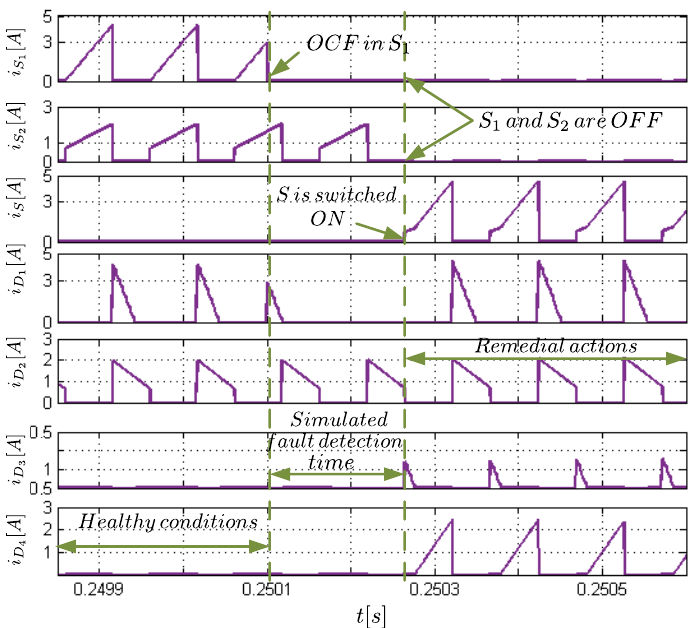
Figure 15. OCF in S 1 at t = 0.25 s: currents in the switches and the diodes. Currents flowing through the inductors L 1 and L 2 , before and after the OCF, are shown in Figure 16. The current i L 1 drops to zero during the disconnection time between the PV and the buck converter, while the current i L 2 is not modified by this failure. The current i L 1 is slightly disturbed after the reconfiguration of the converter, but returns quickly to its initial waveform. Figure 16 illustrates that the operating modes of inductors L 1 (DCM) and L 2 (CCM) are respected.